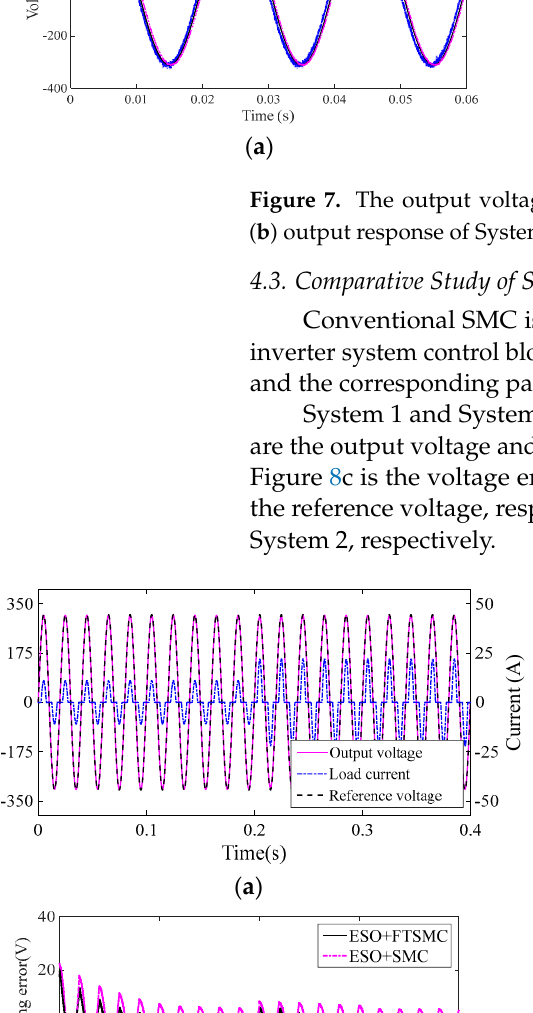
Figure 7. The output voltages of two voltage controllers: ( a ) output response of System 1 and ( b ) output response of System 2.